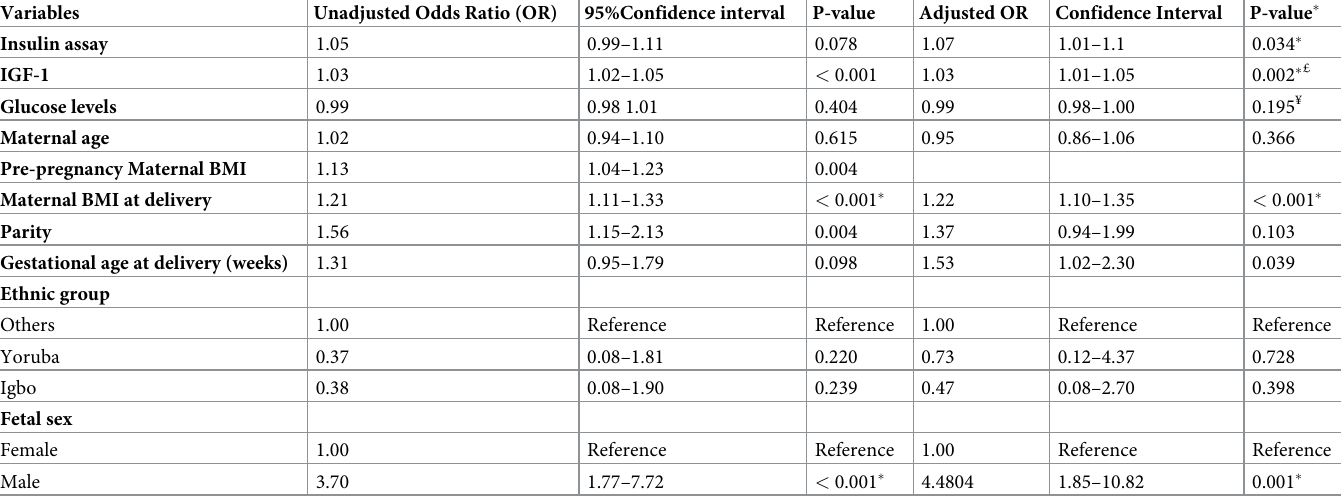
Table 2. Logistic regression of the association between insulin, insulin-like growth factor glucose and fetal macrosomia.